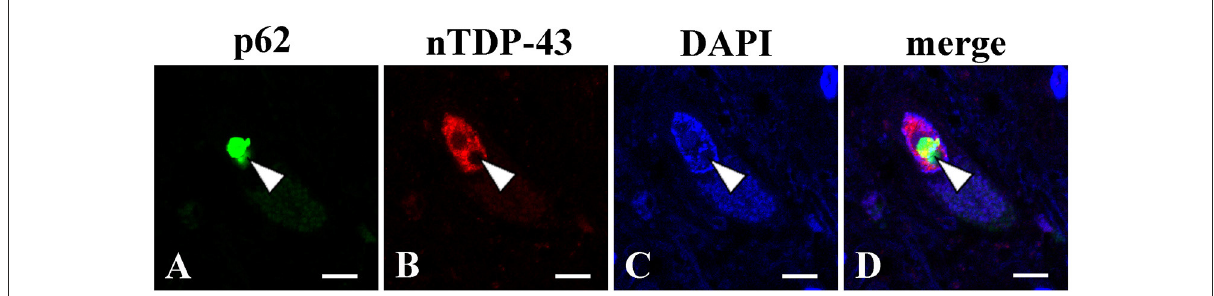
FIGURE3 Double immunofluorescence analysis using the lumber spinal cord (L5). A p62 immunopositive-intranuclear inclusion (A) present with native TDP-43 (nTDP-43) (B) in the nucleus of anterior horn motor neuron. p62 (A) ; nTDP-43 (B) ; 4’,6-diamidino-2-phenylindole (DAPI) (C) ; merged image (D) . Bars = 10 µ